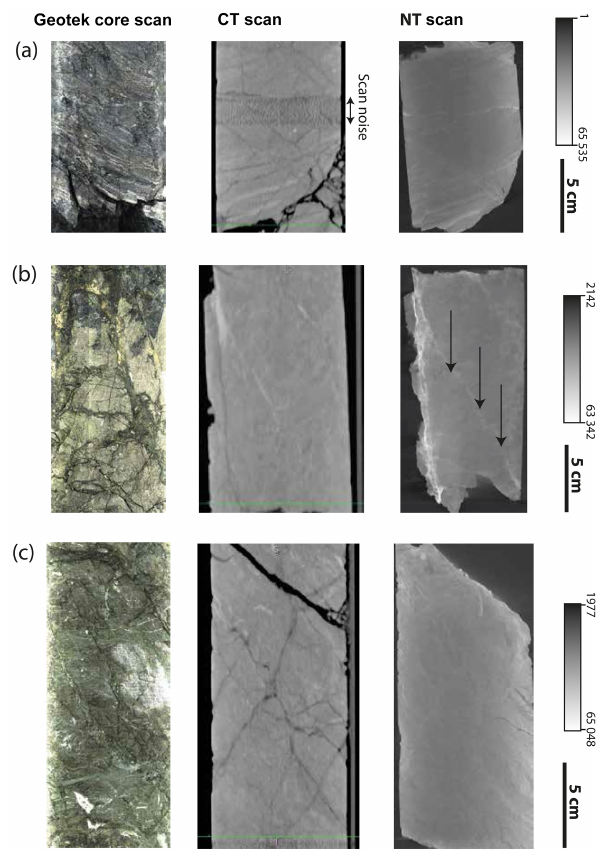
Figure 3. Comparison of 180 ◦ unrolled Geotek images and 2- D core axial-parallel CT and NT slice images of DFDP-1 for ultramylonite intervals. For core section intervals (borehole_core run and section_depth interval from the top of the core section in cm) (a) DFDP-1A_55-1_82-95 (depth interval 75.82–75.95m), (b) DFDP-1B_49-1_35-50 (115.85–116.00m), and (c) DFDP- 1B_35-1_70-88 (102.57–102.75m). Arrows in (b) identify a clay- enriched fracture in the NT image that is not identified in the CT images. Greyscale refers to NT images, and all CT images have a greyscale of CT